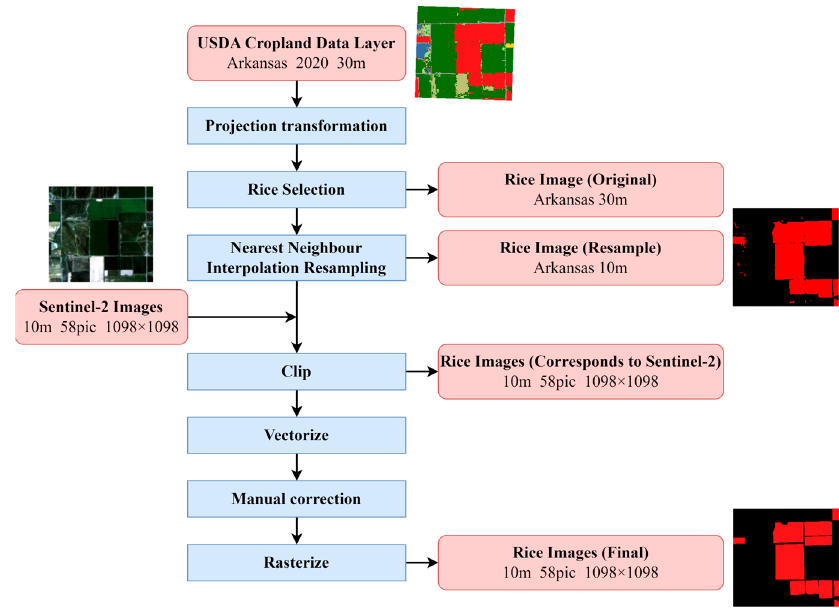
Figure 3. Reference data preprocessing steps.